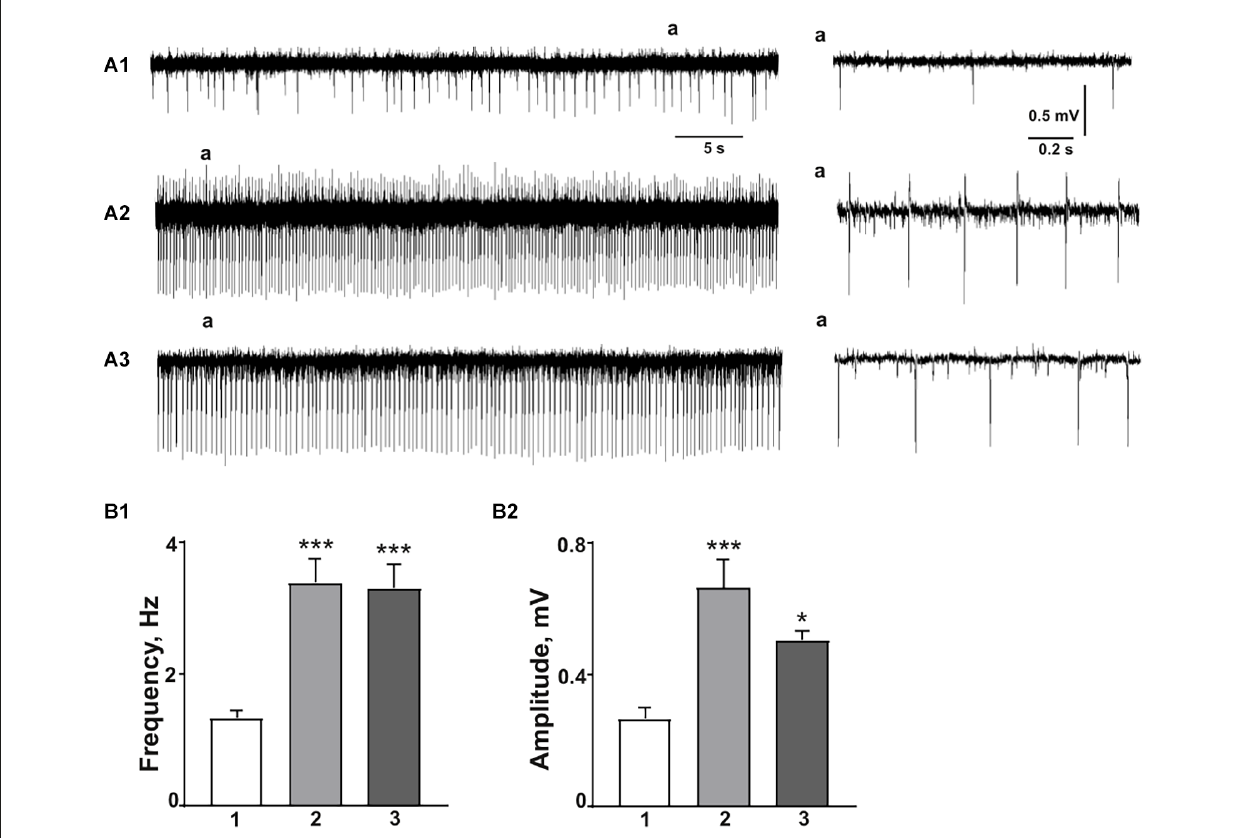
FIGURE1 EffectofthrombininplasmaionicmediaontheinductionofSLAofCA1subfieldcomparedtoLi-pilocarpineseizures. (A1)